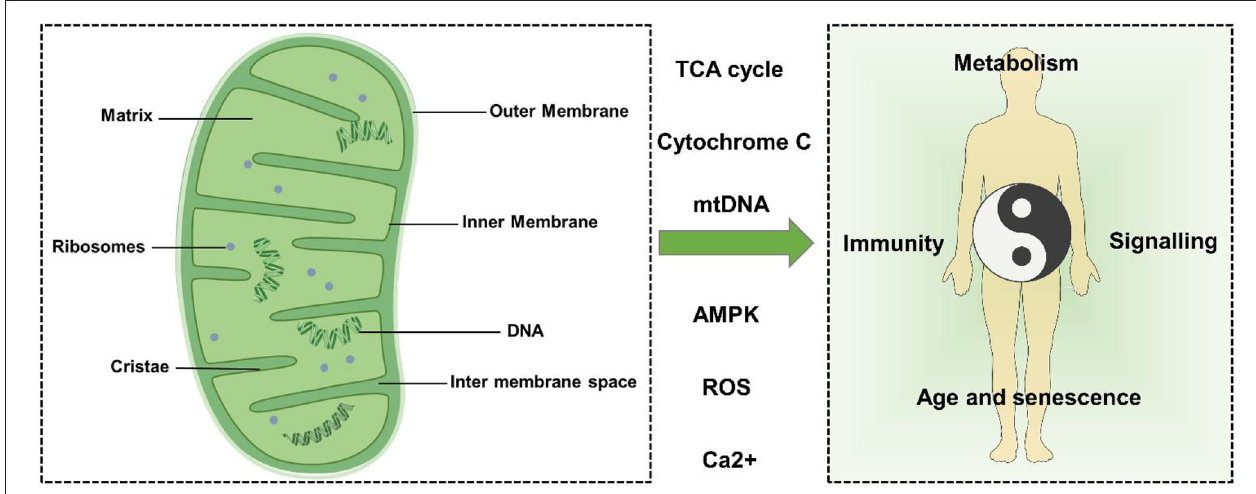
FIGURE 1 | Mitochondrial structure and function. Mitochondria can be divided into four functional regions from outside to inside: outer mitochondrial membrane, intermembrane space, inner mitochondrial membrane, and mitochondrial matrix. Mitochondria can regulate metabolism, signal transduction, immune regulation, cell senescence, and death through TCA cycle metabolites, cytochrome c (Cytc), mtDNA, Ca 2 + , ROS, AMPK, and other factors, thus affecting the balance of the human